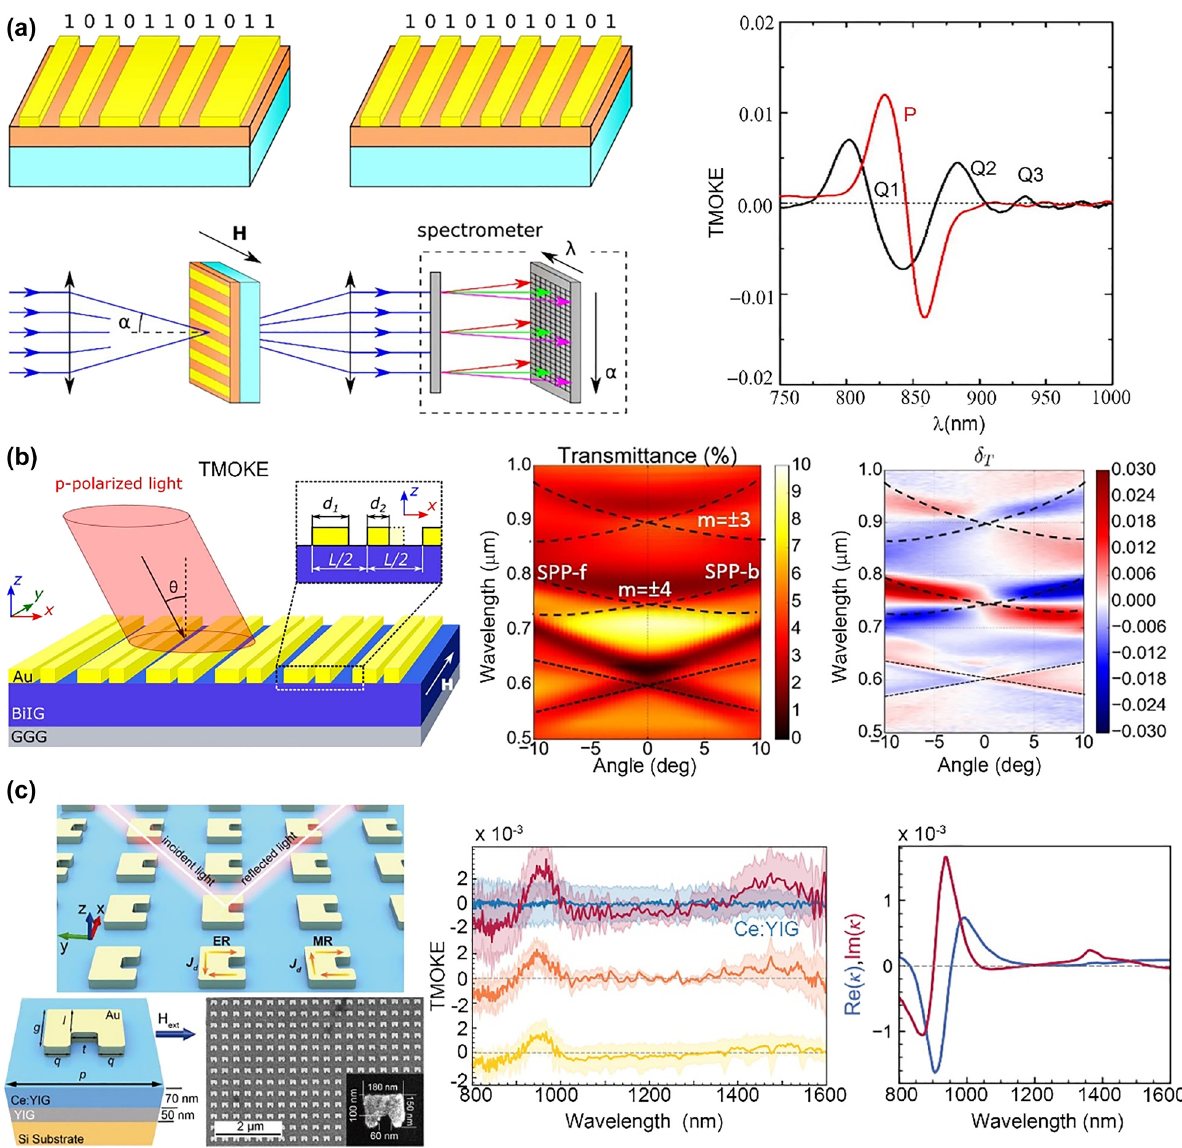
Figure 3: Recent developments of magnetoplasmonic devices with aperiodic/asymmetry structures. (a)MagnetoplasmonicquasicrystalswithmultibandenhancementoftheMOresponse.TherightfigurepresentsTMOKEspectrumforperiodic (redcurve)andquasiperiodic structures (blackcurve).(b)Magnetoplasmoniccrystalswith brokenspatialandtimesymmetry.Themiddleand right figures show the transmittance and TMOKE spectra as a function of the wavelengths and incident angles. A large TMOKE is observed under normal incidence at the SPR wavelength. (c) Magnetoplasmonic nanostructures with asymmetric structure (splitting ring resonator, SRR). The middle figure displays the s-polarized TMOKE under 45 ° (red), 50 ° (orange) and 55 ° (yellow) incidence. The right fi gure presents the equivalent off-diagonal elements of the permeability tensor of metamaterials at near-infrared wavelengths. The panels of this fi gure contain pictures adapted from References [92 –